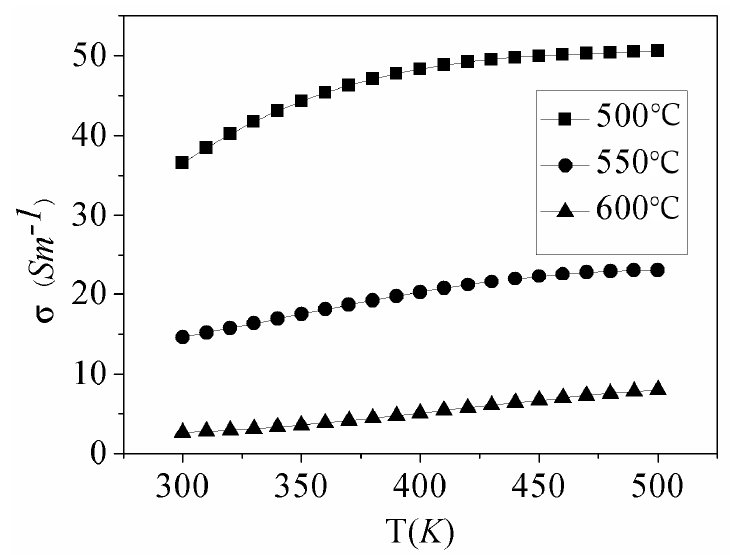
Figure 5. Electrical conductivity of (Bi 0.48 Sb 1.52 )Te 3 thick films as a function of temperature.